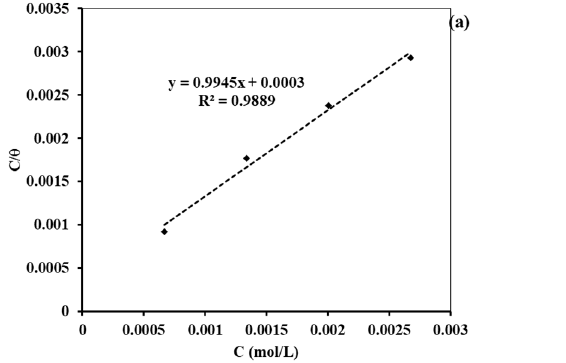
Table 5. Electrochemical impedance parameters derived from the equivalent circuit using Z-view software.